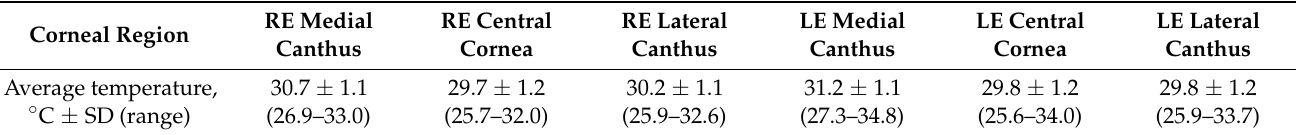
Table 2. Descriptive statistics of OST measurements in the corneal regions.